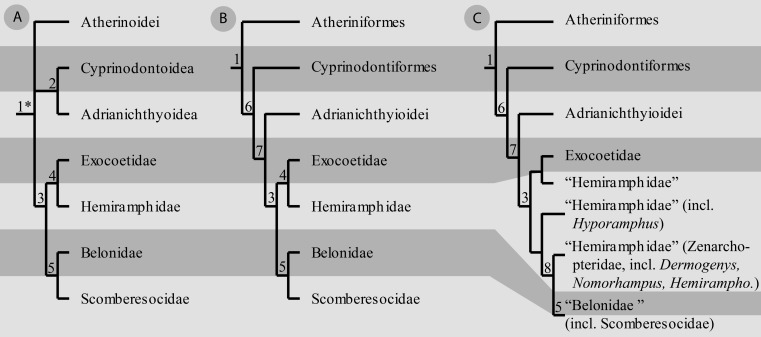
Alternative topologies for atherinomorph interrelationship as referred in the literature.(A) Rosen (1964), (B) Rosen & Parenti (1981), (C) Lovejoy, Iranpour & Collette (2004). Note the different arrangement of Cyprinodontea (6), Hemiramphidae, and the position of Scomberesocidae; corresponding taxa are highlighted. Numbers of non-terminal clades: 1, Atherinomorpha (1*: clade named as “Atheriniformes” by Rosen, 1964); 2, Cyprinodontoidei; 3, Exocoetoidei; 4, Exocoetoidea; 5, Scomberesocoidea; 6, Cyprinodontea; 7, Beloniformes, 8, N.N.